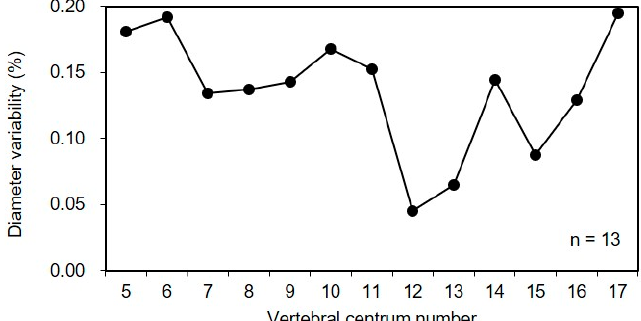
Figure 2. Variability of vertebral centrum diameter for each vertebra.